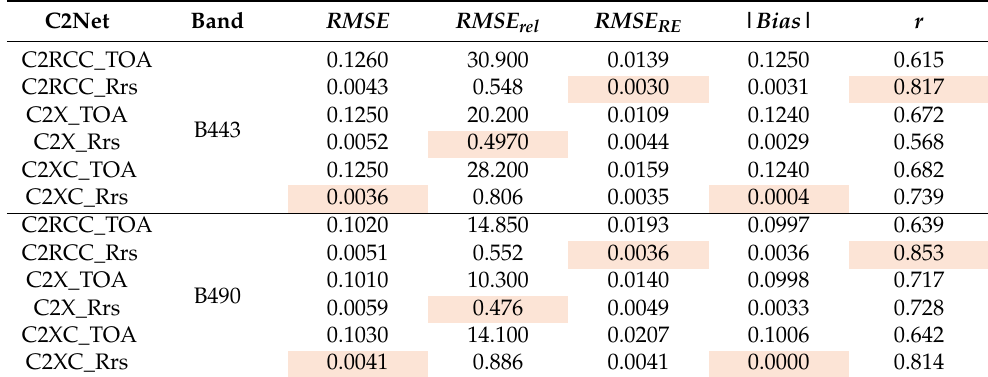
Table A1. Band statistics for TOA and Rrs derived from C2-Nets datasets. Best results for each band and statistic are